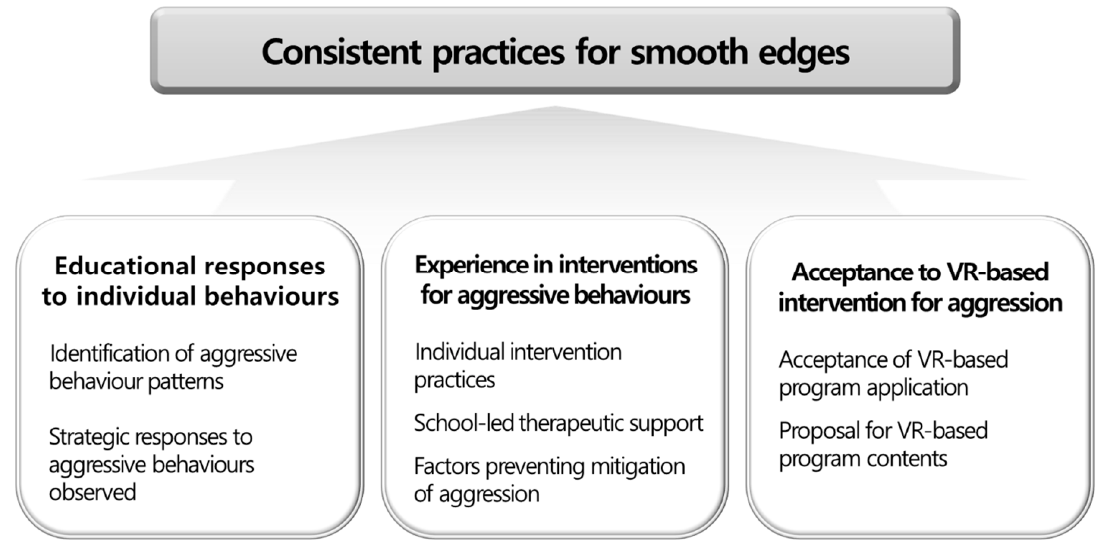
Figure 1. Core theme, categories, and sub-themes through qualitative analysis.